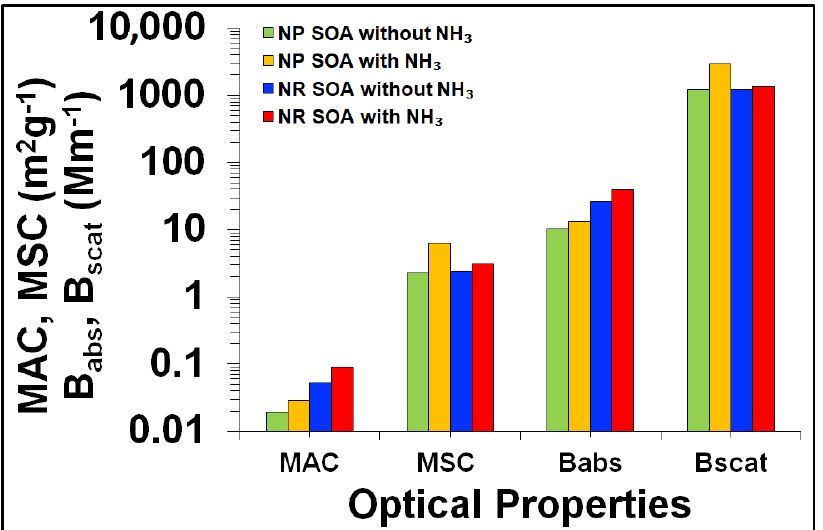
Figure 11. Summary of the effects of NH 3 on the optical characteristics of toluene SOA, i.e., MAC MSC, B abs and B scat at 80% RH under low and high NOx conditions (data are plotted using a log scale).